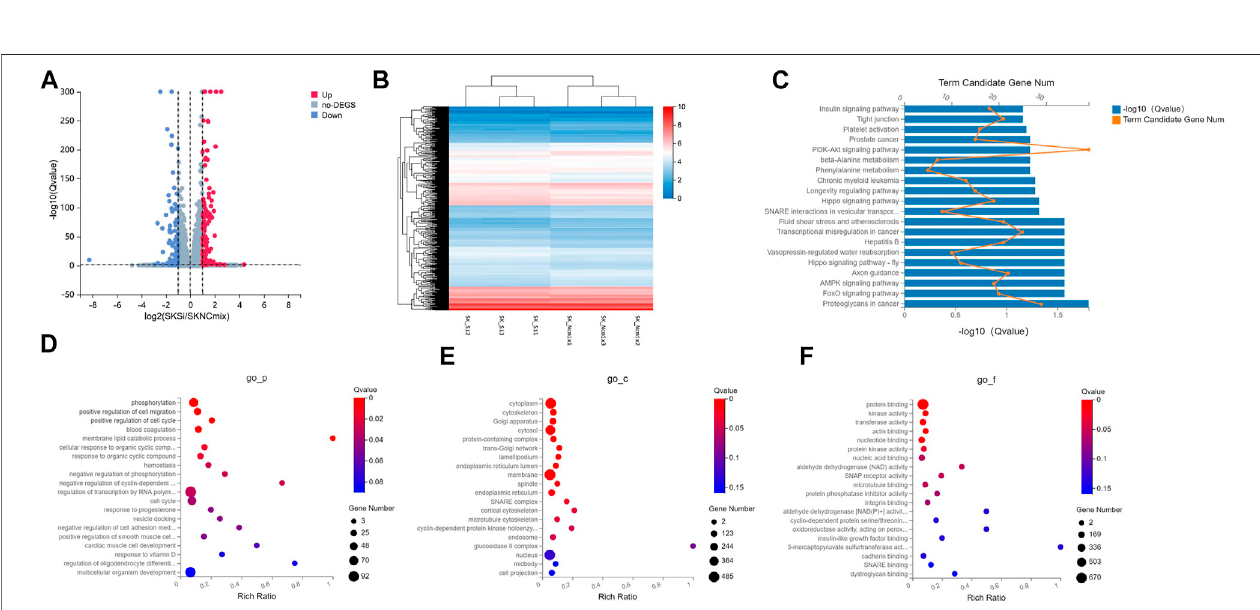
FIGURE3| GOandKEGGanalysisofDEGsintheovariancancercelllineSKOV3. (A) VolcanoplotofDEGsintheWT1knockdowngroup(SKSi)andcontrolgroup (SKNCmix). (B) Heat map of mRNA expression between SKSi and SKNCmix. mRNA expression shown gradually increases from blue to red. (C) KEGG analysis of the DEGs in SKOV3. GO analysis of the DEGs in SKOV3 (D) Biological processes, (E) Cellular components, and (F) Molecular functions. KEGG: Kyoto Encyclopedia of Genesand Genomes; GO:Geneontology; DEGs: differentially expressed genes;go - P :biological process inGOanalysis;go-c:cellular componentinGOanalysis; go-f: molecular function in GO